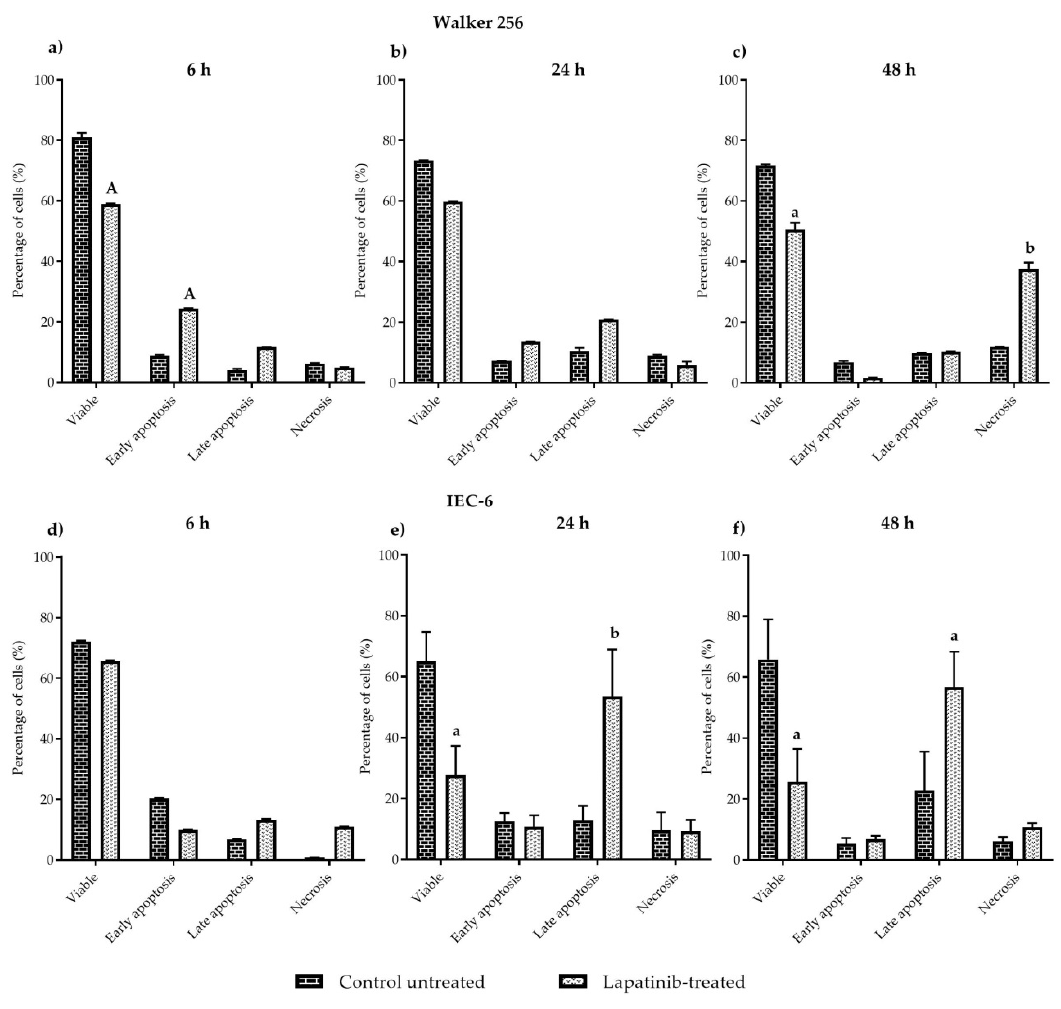
Figure 2. The percentage of viable, early apoptotic, late apoptotic and necrotic cells in lapatinib-treated Walker 256 cells compared to control untreated at ( a ) 6 h ( b ) 24 h ( c ) 48 h incubation and lapatinib-treated IEC-6 cells compared to control untreated at ( d ) 6 h ( e ) 24 h ( f ) 48 h incubation as quantified via FACS analysis. Graph shown for each cell line is representative of experiments conducted. Results shown on the graph are presented as mean ± S.E.M ( n = 6). Results were compared with control untreated cells at the same incubation time in the same category. Data showing the letters were significantly different at the level of p < 0.05. a for p < 0.05 compared to control untreated cells, b for p < 0.01 compared to control untreated cells, A for p < 0.0001 compared to control untreated cells.